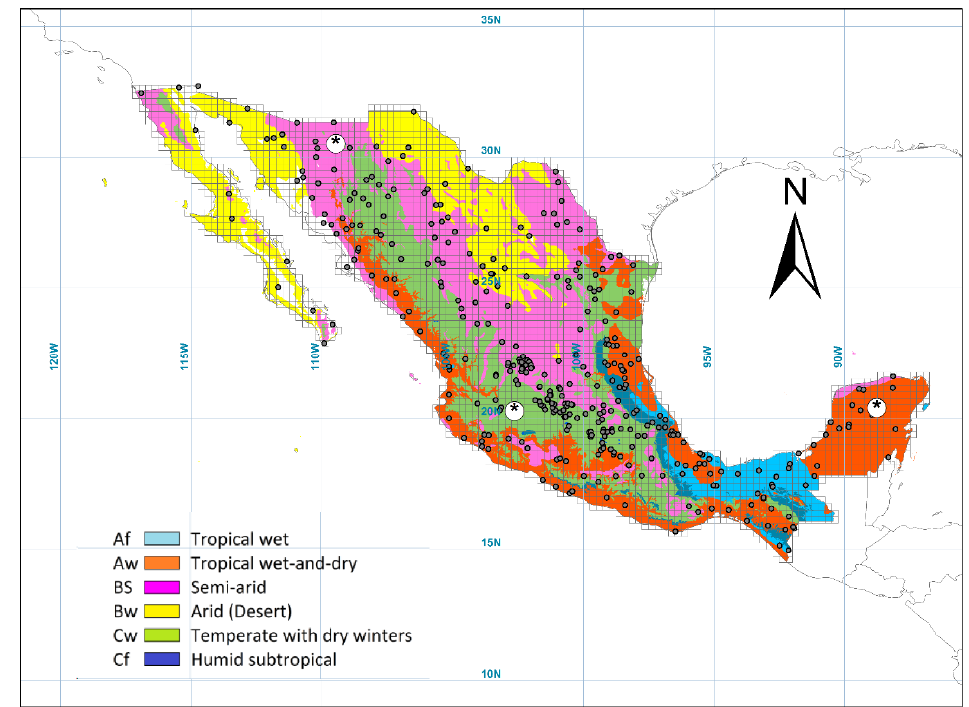
Figure 1. Climate classification of Mexico, location of the 364 rain gauges used to derive the drought index from the MDM and TRMM 3B42 spatial resolution grid (0.25° × 0.25°). Large circles with the asterisk represent those rain gauges whose SPI was compared against the SPI derived from the TRMM 3B42.